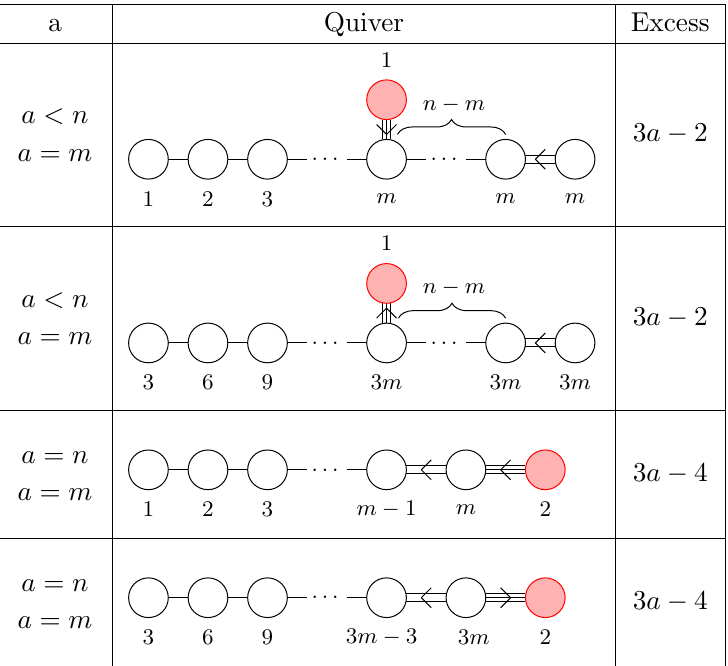
Table 31 . Exotic minimally unbalanced quivers with G = Sp(2 n ) and an extra triple laced edge. the total number of balanced nodes. Minimally unbalanced quivers with exceptional global symmetry (i.e. of EF G -type) are found for each di(cid:11)erent case (i.e. for each possible node to which the unbalanced node is attached). In case of E 4 due to the Z outer automorphism invariance of the E 2